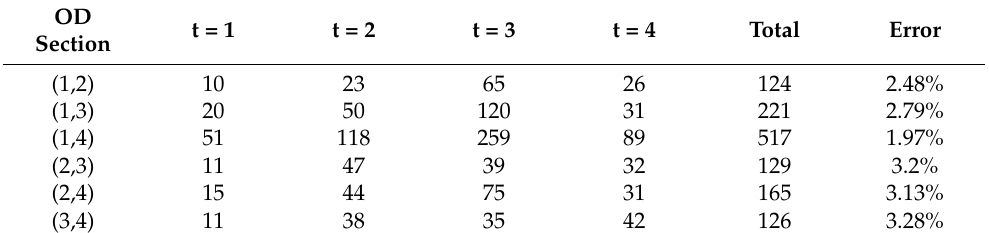
Table 7. Statistical table of average value and error of ticket-purchasing demand.